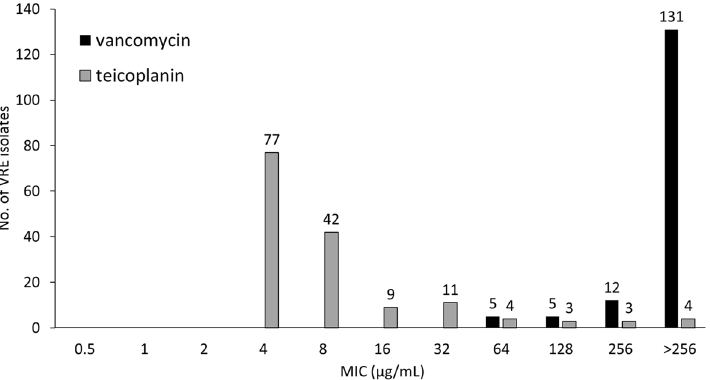
Figure 1. Minimum inhibitory concentration of vancomycin and teicoplanin for vancomycin-resistant Enterococcus faecium isolates during the outbreak. According to the criteria of the Clinical and Laboratory Standards Institute, breakpoints of vancomycin and teicoplanin are 4 µg/mL and 8 µg/mL, respectively (n =